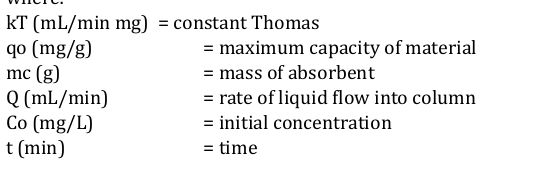
Figure 5: Linear plot of Yoon and Nelson model for ammonia adsorption